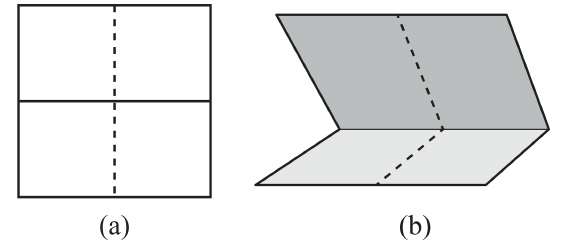
Figure 15. The UP state (b) based on the crease pattern (a) , cannot fold along the creases represented by the dotted line because the creases are not collinear.